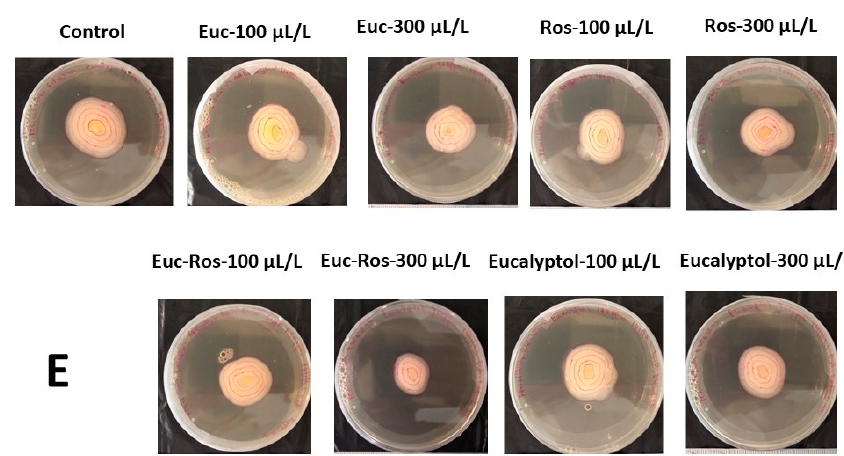
Figure 1. Effects of ( A ) eucalyptus EO (Euc), ( B ) rosemary EO (Ros), ( C ) their 50:50 mixture (Euc + Ros) and ( D ) eucalyptol on P. expansum colony growth on PDA medium at 7 °C for 13 days. Significant differences ( p < 0.05) among treatments are represented with different Latin letters; ns indicates no significant differences among the treatments, on the last day. ( E ) Representative image is also presented.